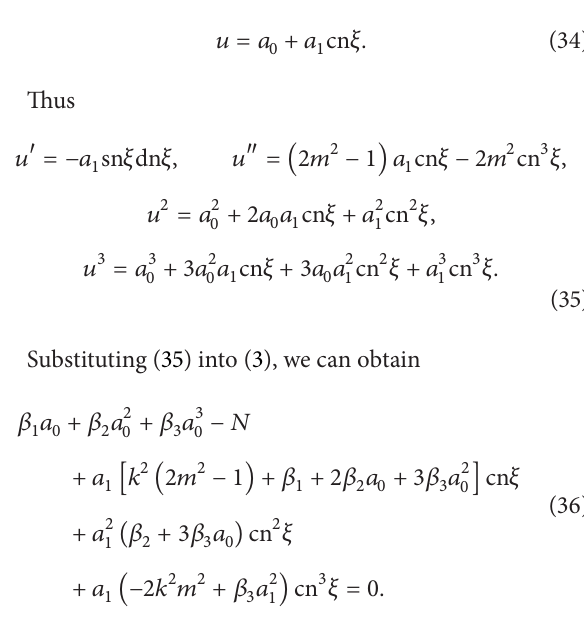
Figure 2: The solitary wave and behavior of the solutions 𝐻(𝑥,𝑡) = 2 − 2 tanh 2 (𝑥 + 𝑡) for 0 ⩽ 𝑡 ⩽ 1 and −10 ⩽ 𝑥 ⩽ 10